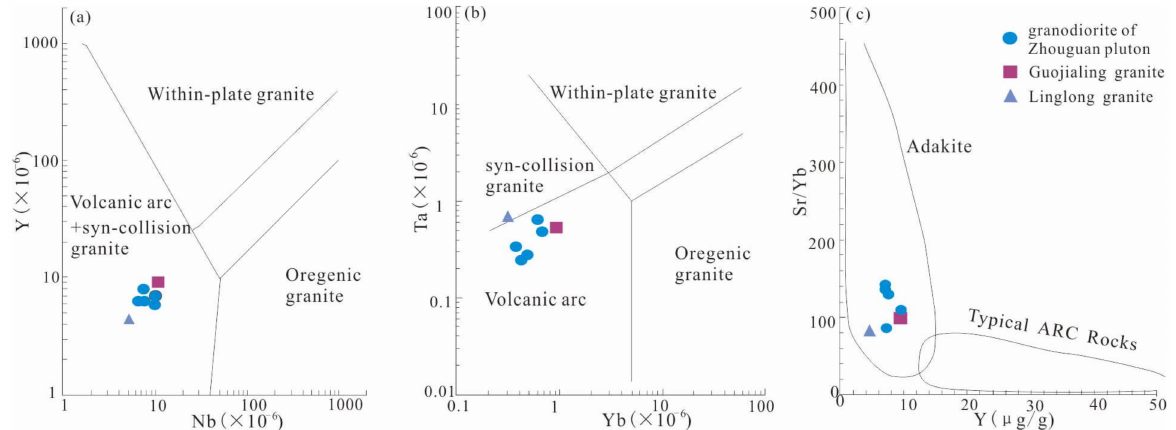
Figure 12. Diagrams of Y vs. tNb ( a ), Ta vs. Yb ( b ) and Sr/Yb vs. Y ( c ) for the Zhouguan granodiorite (after Pearce et al., 1984 [91]; Martin et al., 2005